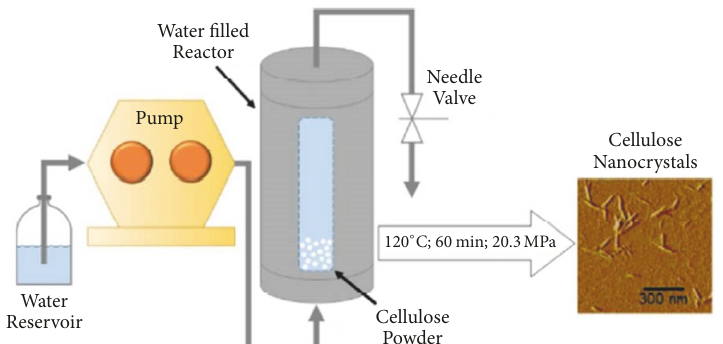
Figure 7: Scheme of subcritical water batch setup